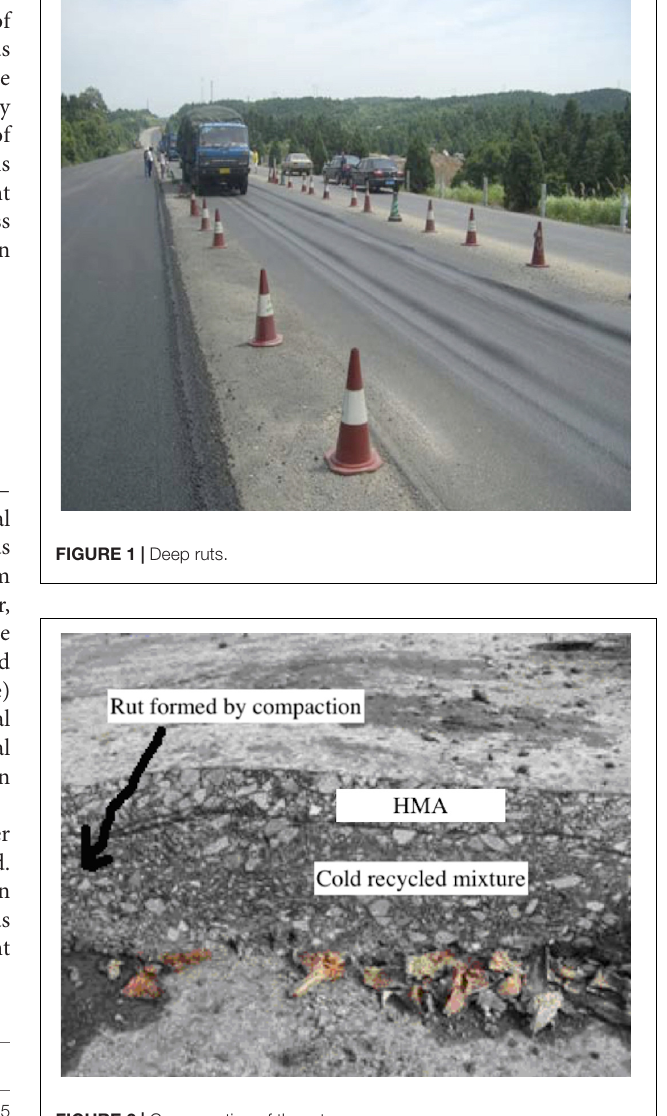
FIGURE 2 | Cross section of the